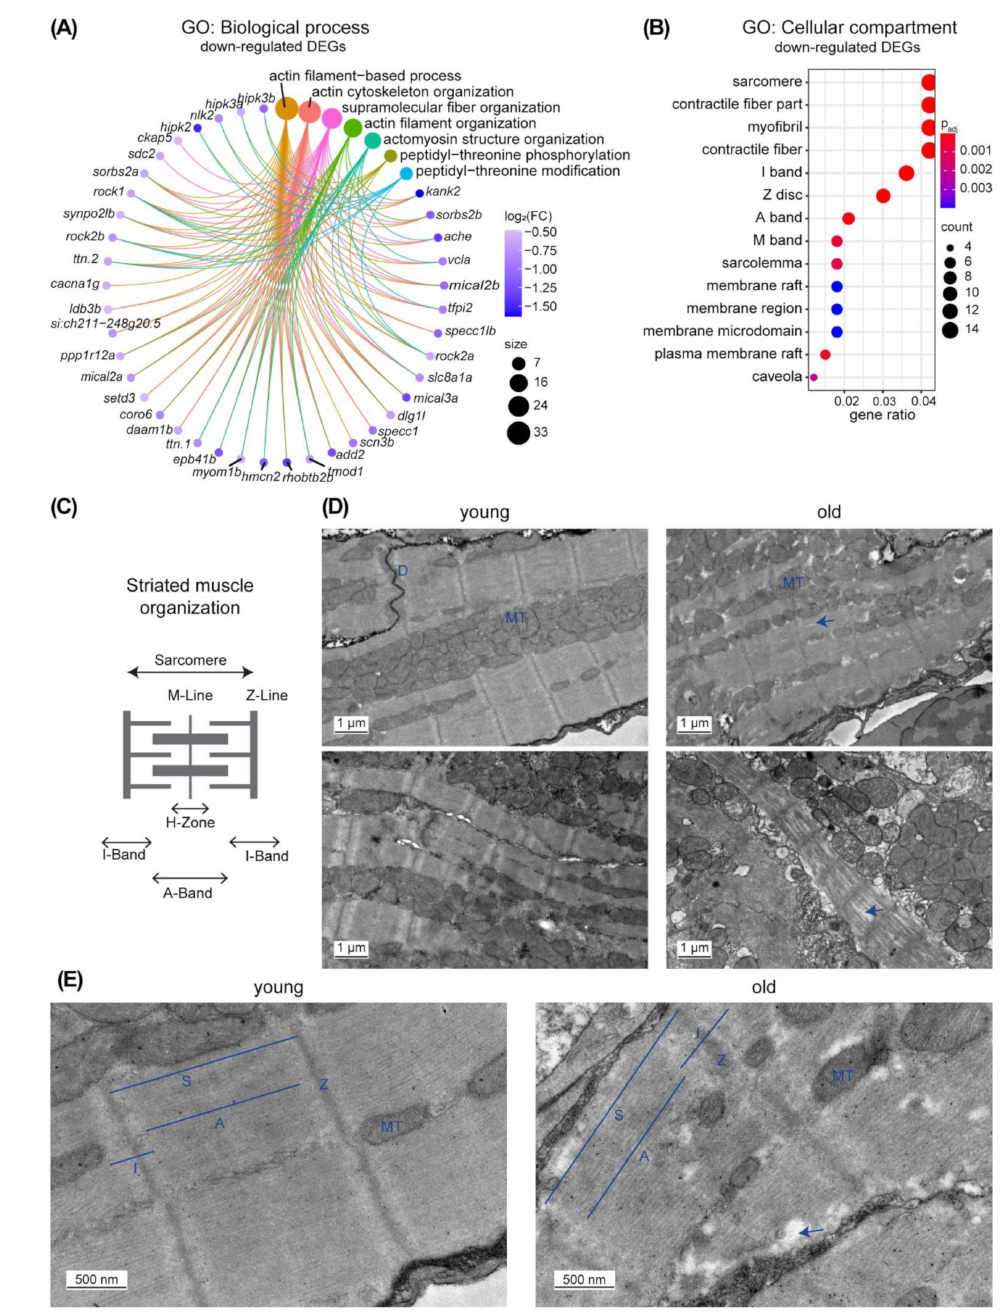
Figure 2. Expression of genes related to the actin filament is changed upon aging. ( A ) Circular plot illustrates the GO terms of the category “biological process” identified as enriched among 488 down regulated DEGs and the respective genes associated with these terms. The size of the GO term circle indicates the number of the genes and the color of the gene circle indicates the fold change (log 2 (FC)) in blue shades. Actin-related terms are prominent. ( B ) Dot plot indicates GO terms of the category “cellular compartments” that are enriched among the 488 down regulated DEGs. The size of the circle indicates the number of the genes, the color the adjusted p -value of the GO term analysis. Terms related to muscle structures are prominent. ( C ) Scheme of the striated muscle organization. ( D ) Electron microscopy pictures of the ventricle of 1-year-old (young) and 5-year-old (old) fish indicate changes in muscle organization in old. Scale bars: 1 µ m. ( E ) Higher magnification picture of striated muscle organization in young and old. Scale bars: 500 nm. D: Desmosome; MT: Mitochondria; S: Sarcomere; I: I-Band; A: A-Band; Z: Z-Line. Arrows indicate to less dense muscle structures in